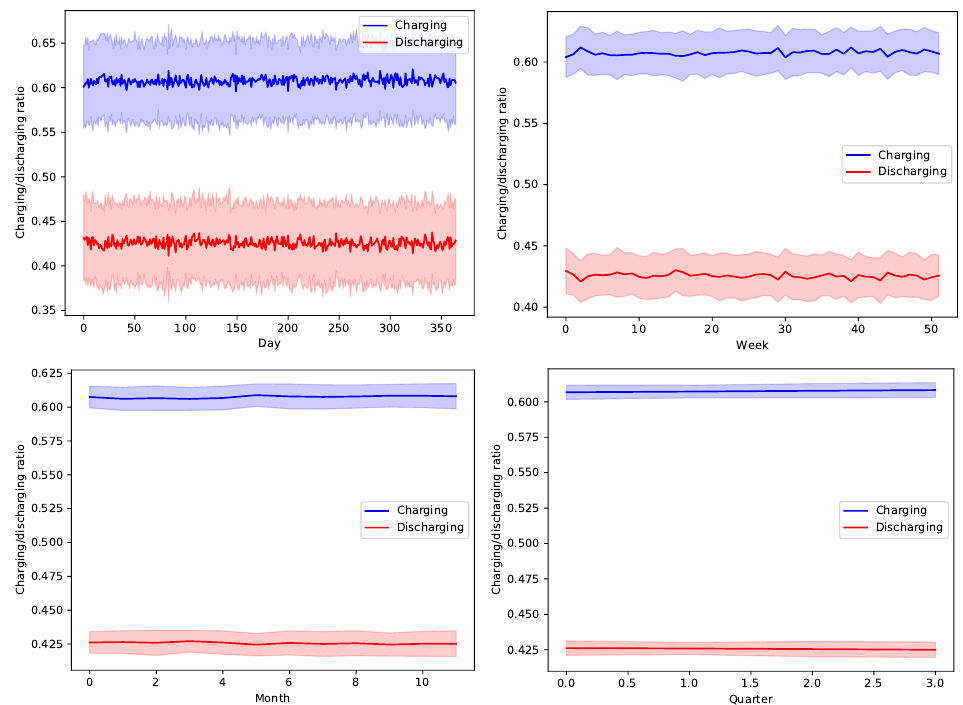
Figure 15. The average temporal charging and discharging ratios of EVs according to the greedy policy with a global certainty level U 50 .